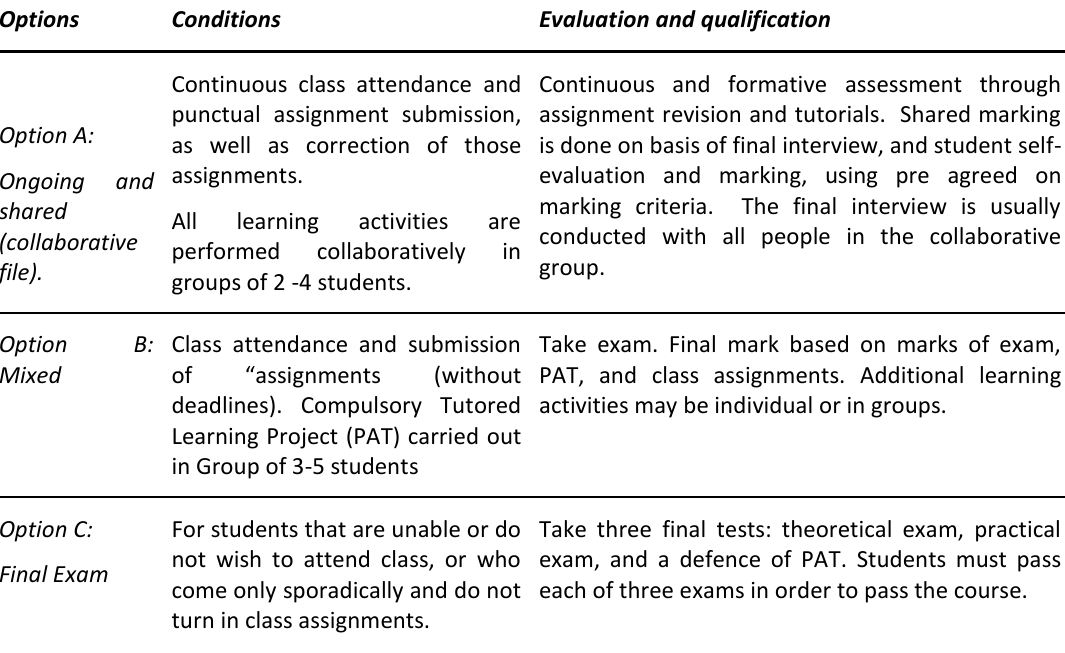
Table 1 – Three options for taking and passing course: Conditions, assessment, and